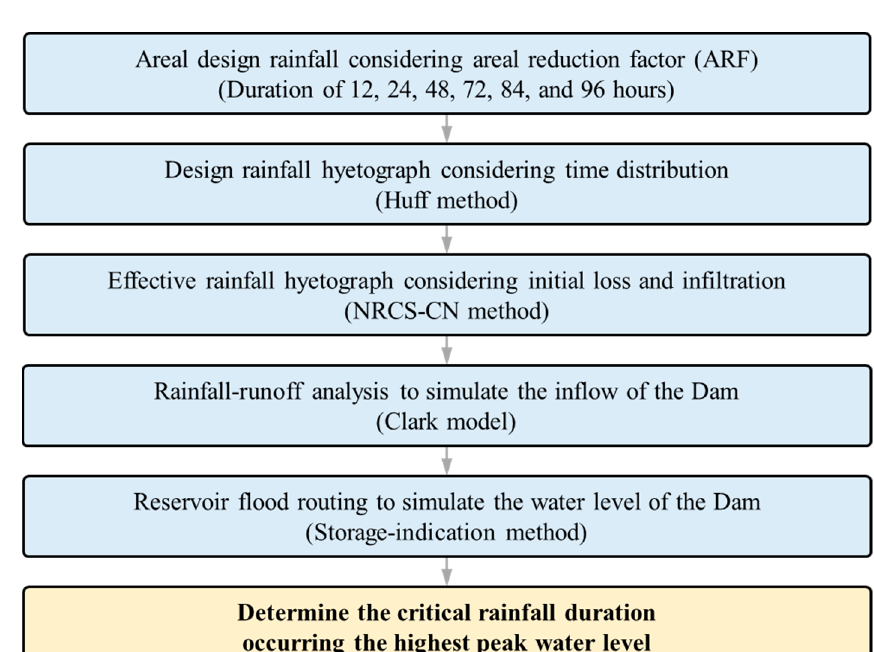
Figure A2. Procedure for determining the critical rainfall duration in this study.